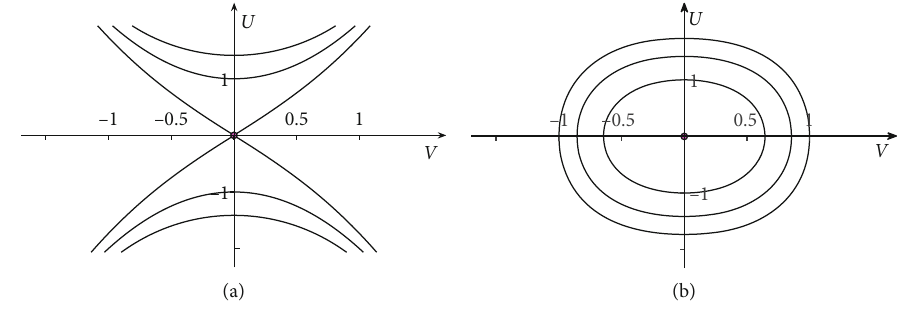
= 1 and (b) a = − 1 . 4 4